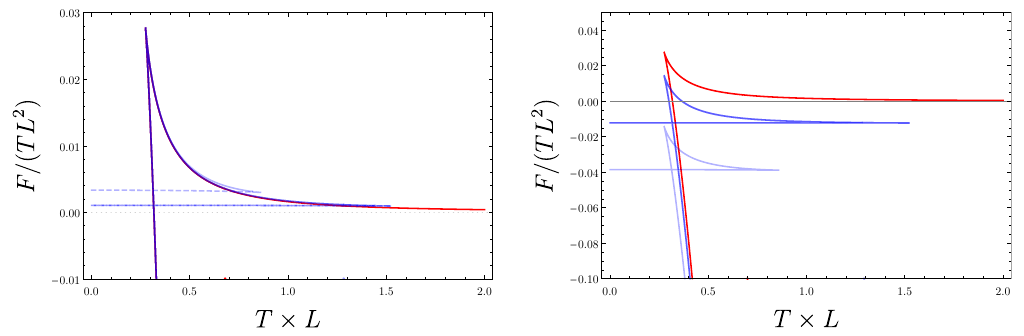
Figure 3 . Hawking-Page transitions in four dimensions . Left : a plot of the free energy using the Wald entropy. Here we indicate negative entropy regions with a dashed curve. Right : a plot of the free energy using the shifted Wald entropy satisfying S corresponds corresponds to the Einstein gravity case with µ = 0, the light-blue curve corresponds 4 to µ = 10 , and the dark-blue curve corresponds to µ = µ c − − | | we have plotted F/T , since the free energy itself has a steep slope that makes it difficult to showcase the